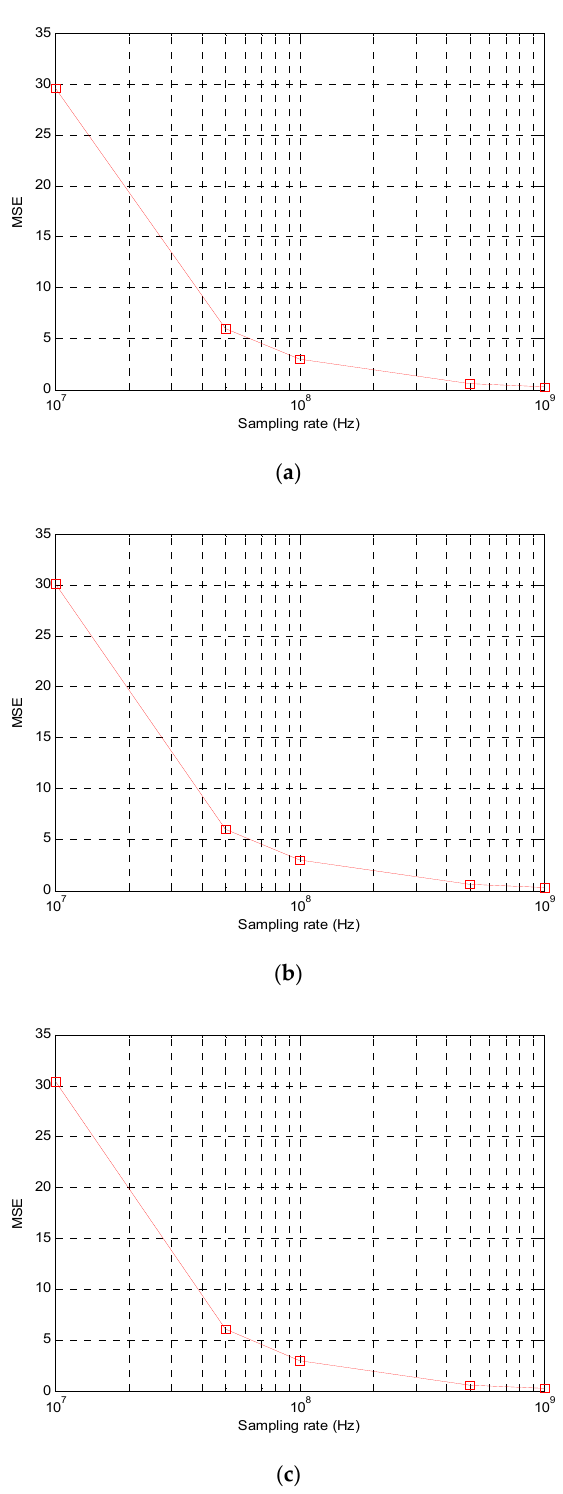
Figure 8. MSE curve of the estimated distance for ( a ) the first case, ( b ) the second case, and ( c ) the third case, for the first set.